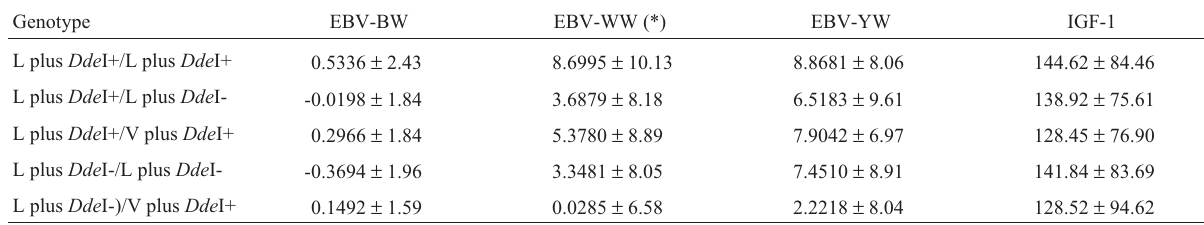
* Significant difference between means (F test, p < 0.05).